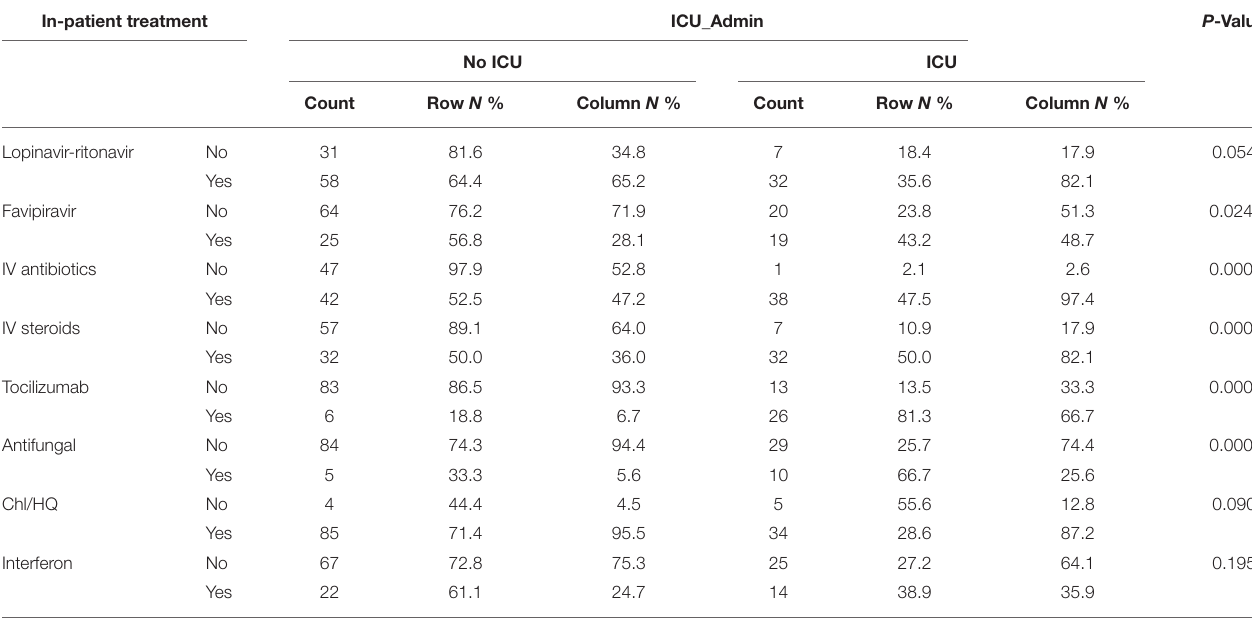
TABLE 5 | Major medications used in the training cohort. In-patient treatment